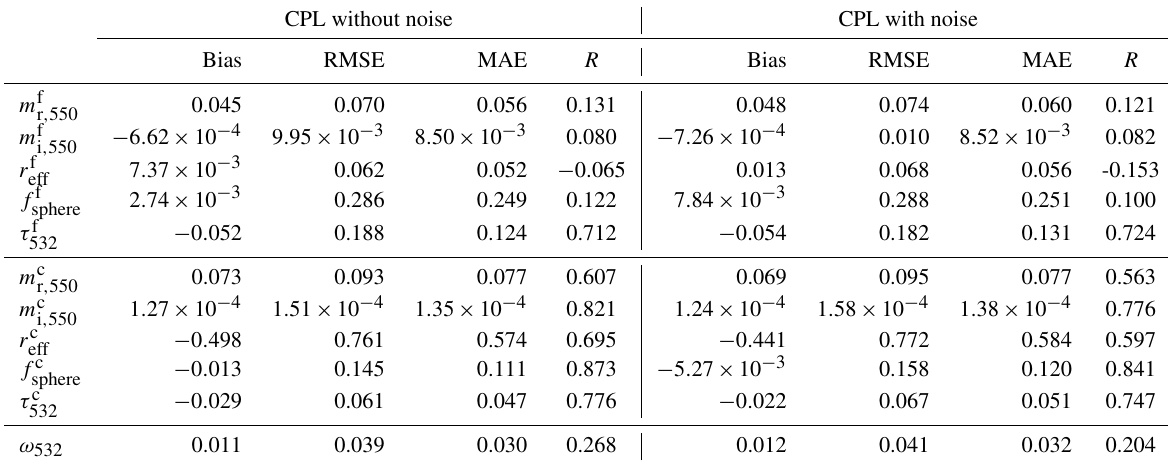
Table 5. Results for retrievals with the simplified CPL configuration with and without noise.